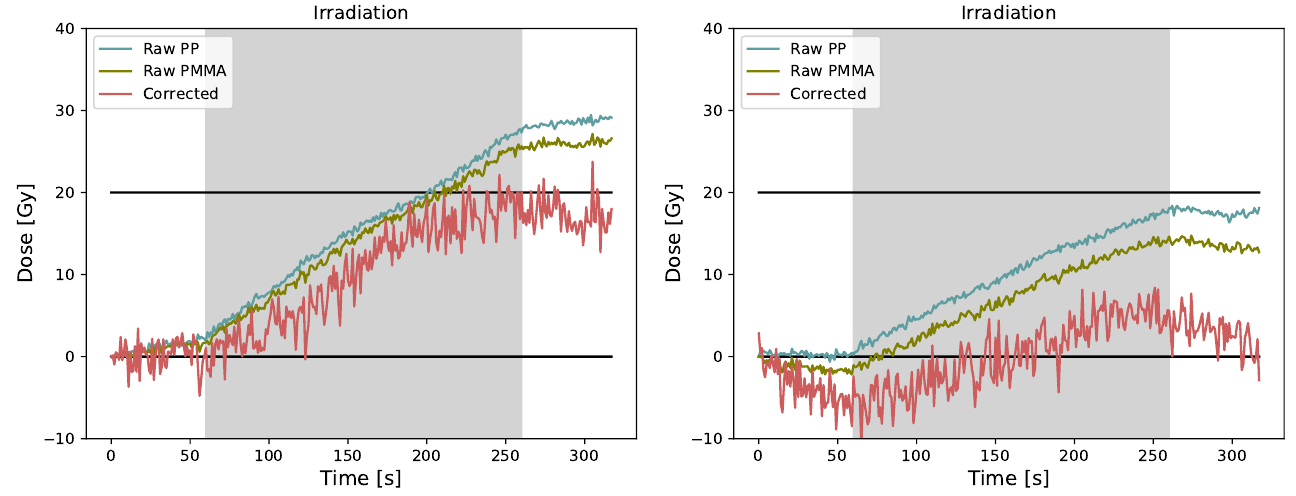
Figure 4. Raw and corrected data were obtained using the two polymer-embedded FBGs (dual grating technique) for ( a ) a case where both FBGs experienced the same temperature variation and ( b ) a case where both FBGs did not experience the same temperature variation.